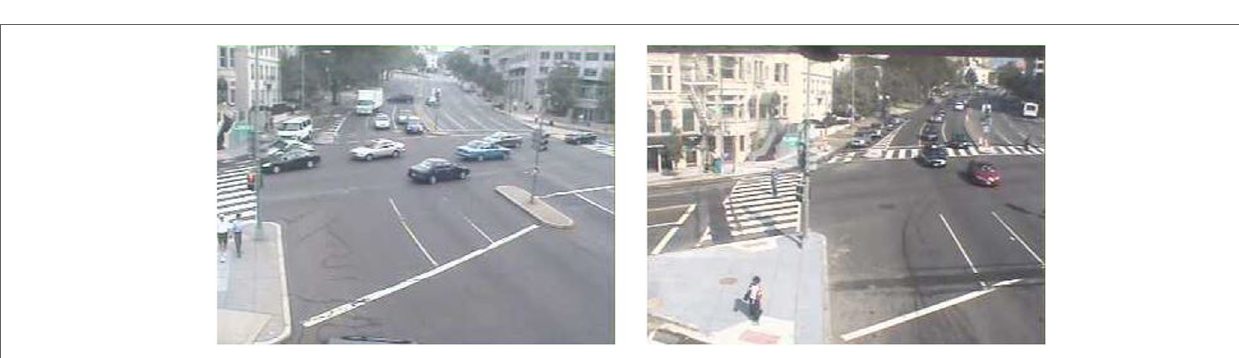
FigUre 1 | residential intersection prior to (left) and following (right) built environment change